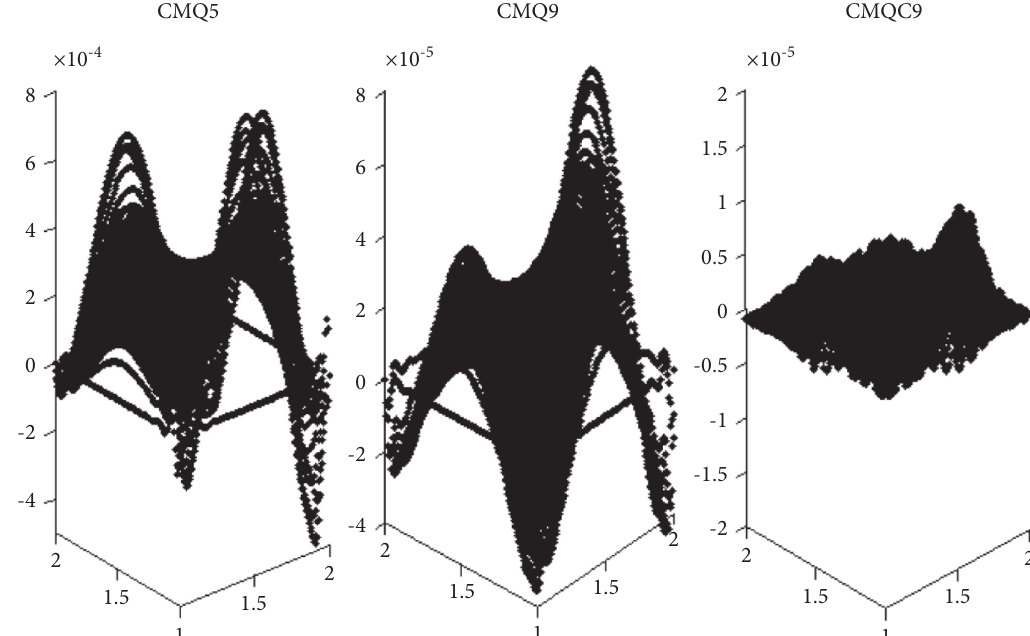
Figure 4: Absolute error surface for field solution on the whole solution